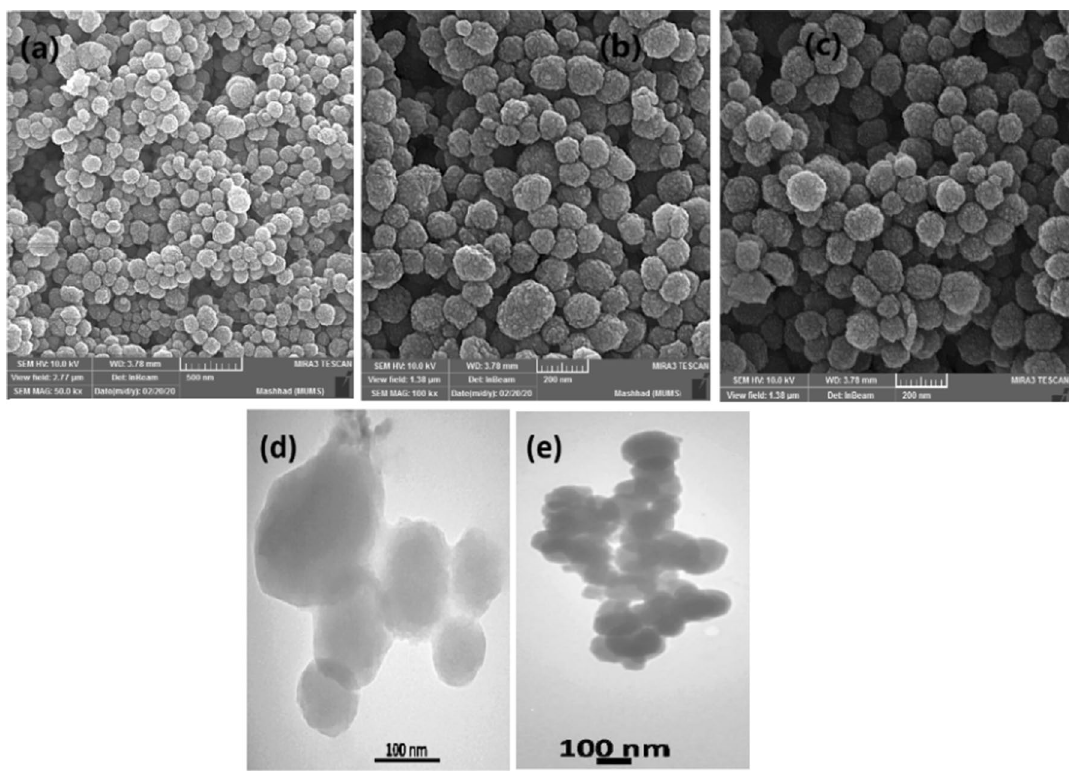
Figure 5. The SEM image of nanosphere KCC-1@NH 2 ( a ) KCC-1, ( b ) KCC-1@NH 2 before use, ( c ) after reuse of six times, and ( d,e ) TEM images of KCC-1@NH 2